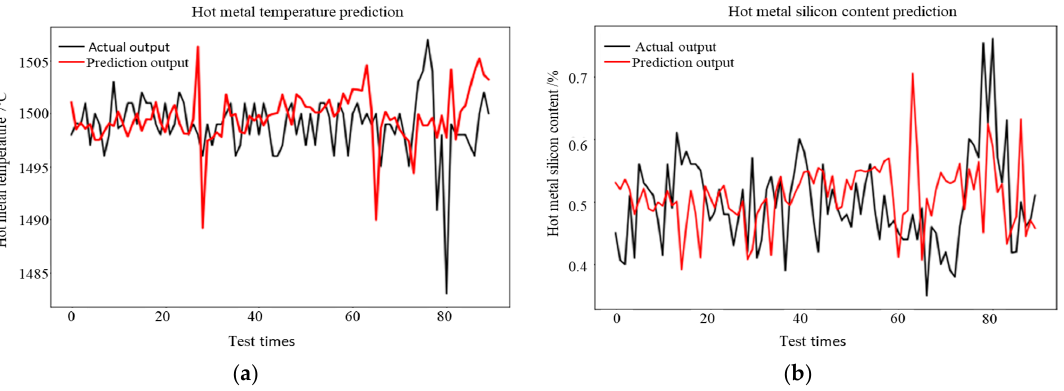
Figure 1. Hot metal temperature and silicon content correlation model: ( a ) comparison between the model prediction and actual hot metal temperature and ( b ) comparison between the model prediction and actual hot metal silicon content.